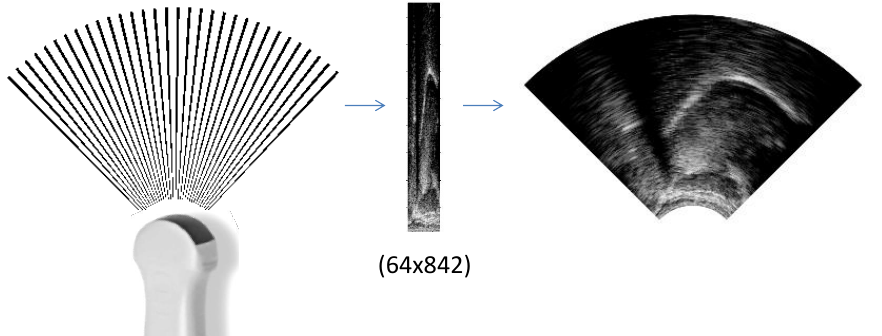
Figure 1. Ultrasond tongue image representations: raw scanlines during recording ( left ), array of raw scanline data ( middle ), and a wedge-formatted image ( right